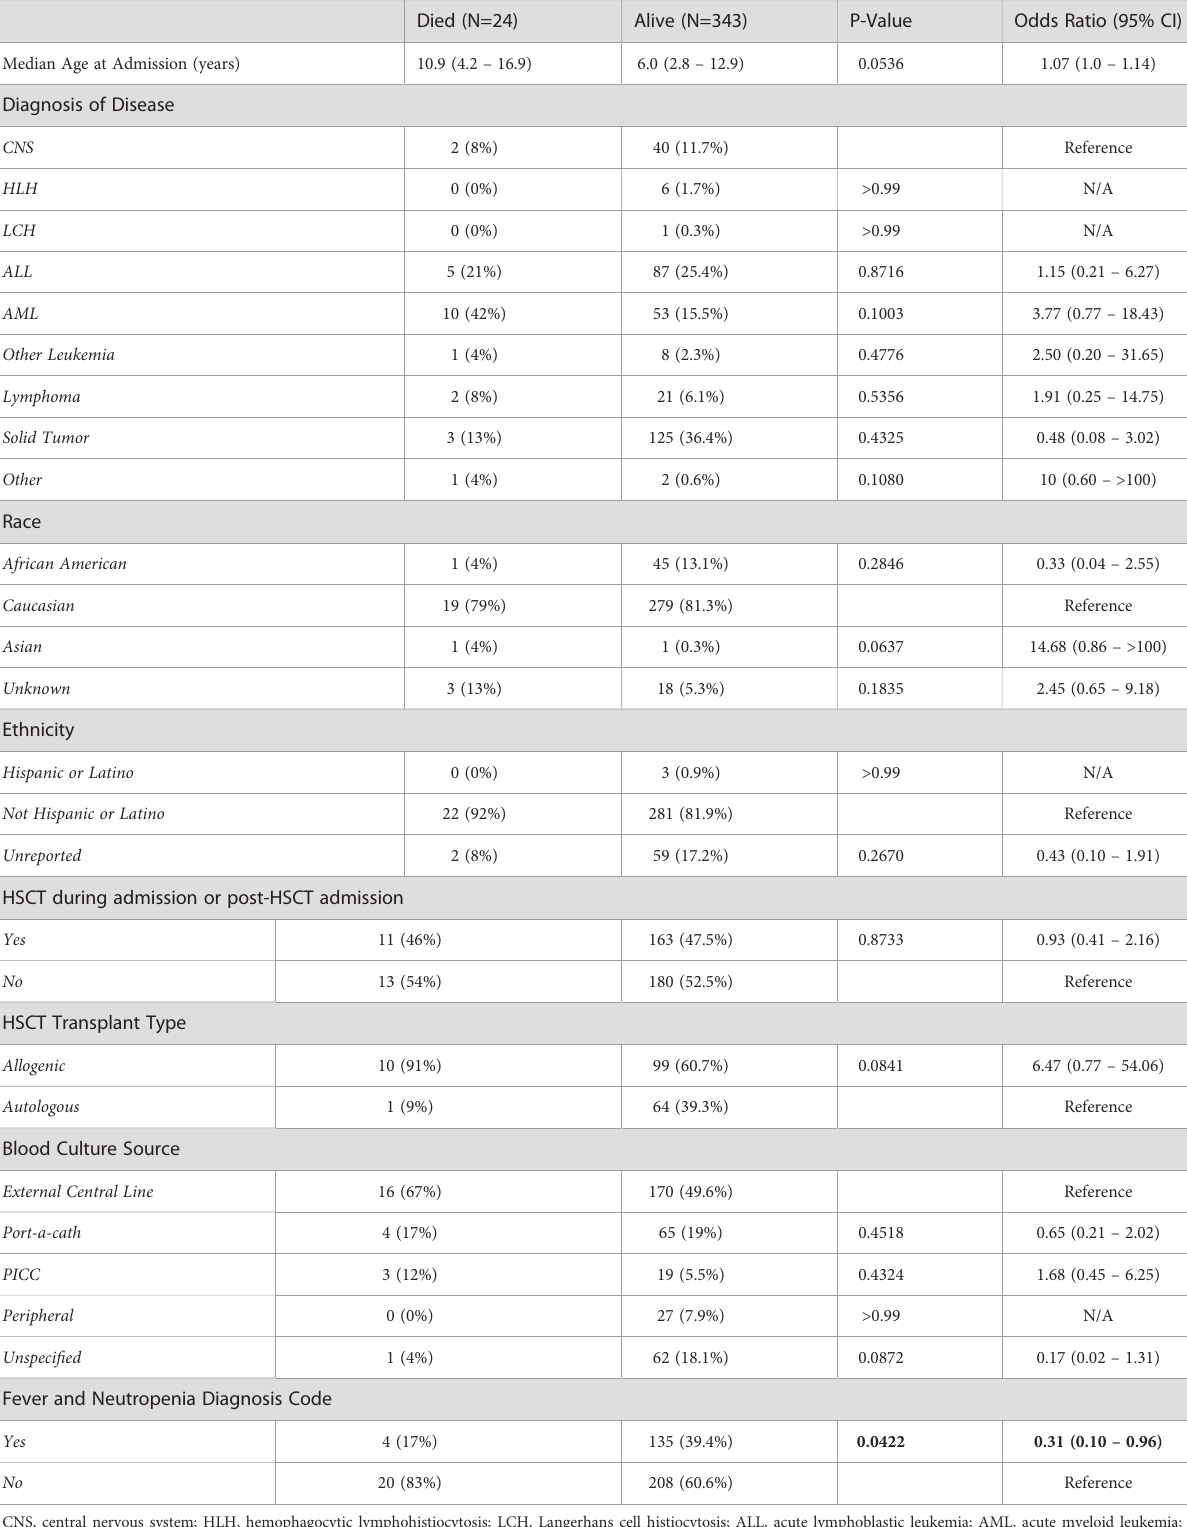
TABLE 5 Univariate Analysis of Risk Factors Associated with Mortality during Admissions with BSI